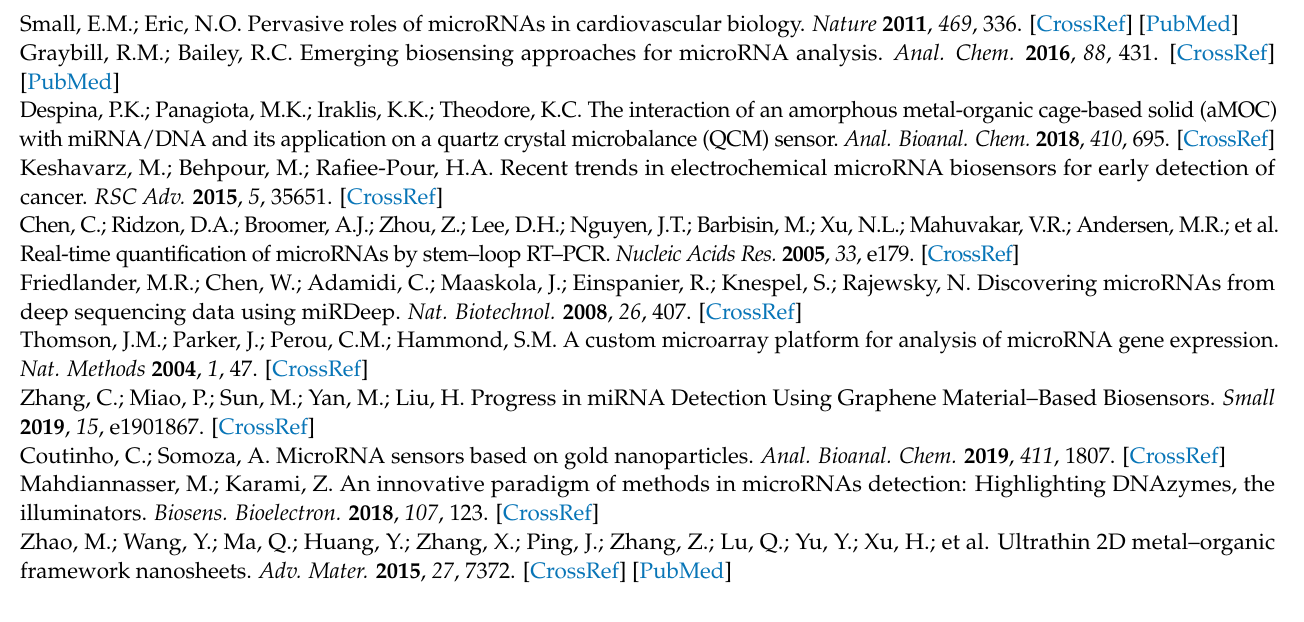
Figure S3: Pore size distribution analysis of EB-TAPB-TFP COF; Figure S4: (a) SEM image of